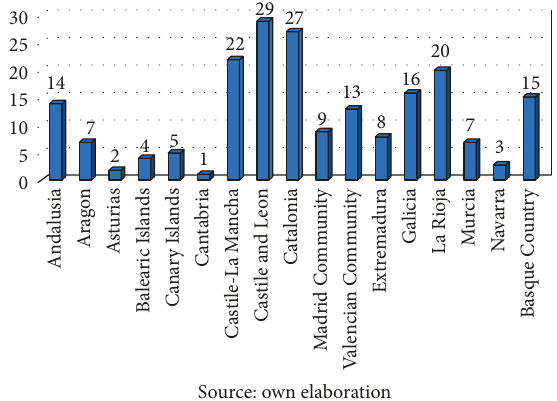
Figure 2: Distribution of the companies in the sample by the autonomous community. Source: own